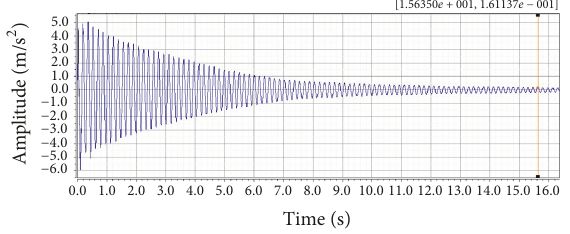
Figure 22: Response of the flexible arm under the smaller frequency ratio.